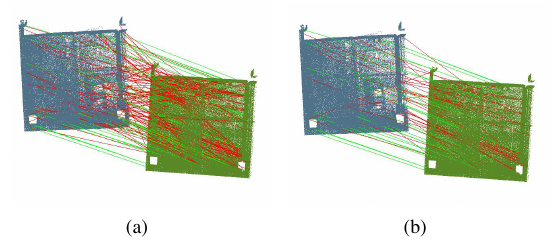
Figure 3. The matched point pairs. Red matching pairs are wrong matching pair and green matching pairs are right matching pair. (a) is the F u matching pairs, the accuracy is 31.5%. (b) is the F i matching pairs, the accuracy is 39.7%. the matching pair in F i and the accuracy is 39.7%. Therefore, F i is selected as the final candidate matching